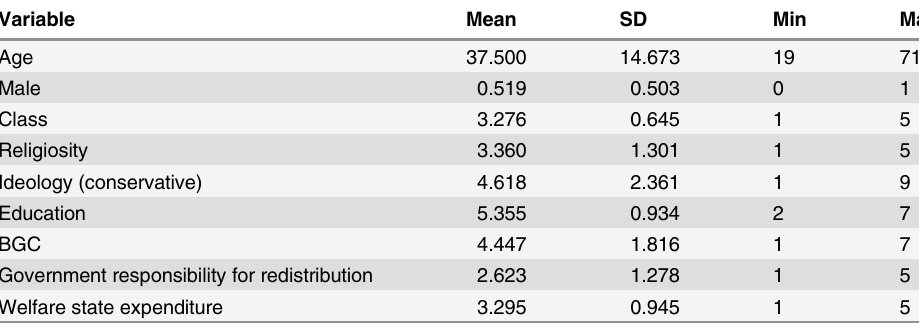
Table 3. Descriptive statistics, American Jews sample (Study